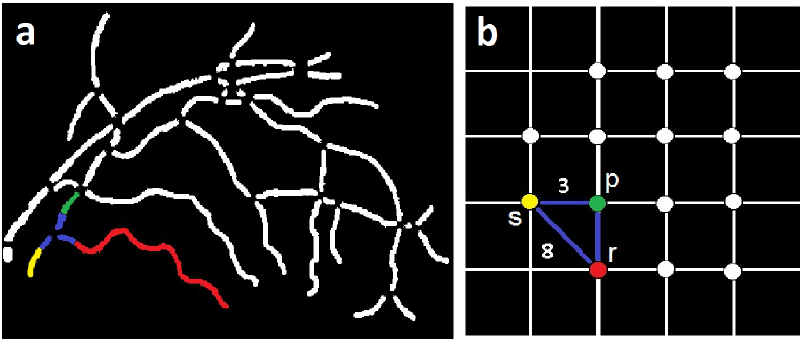
Figure 5. Graph based description: a) Vessel segment map [Width is enlarged for visualization] b) Representative graph structure.